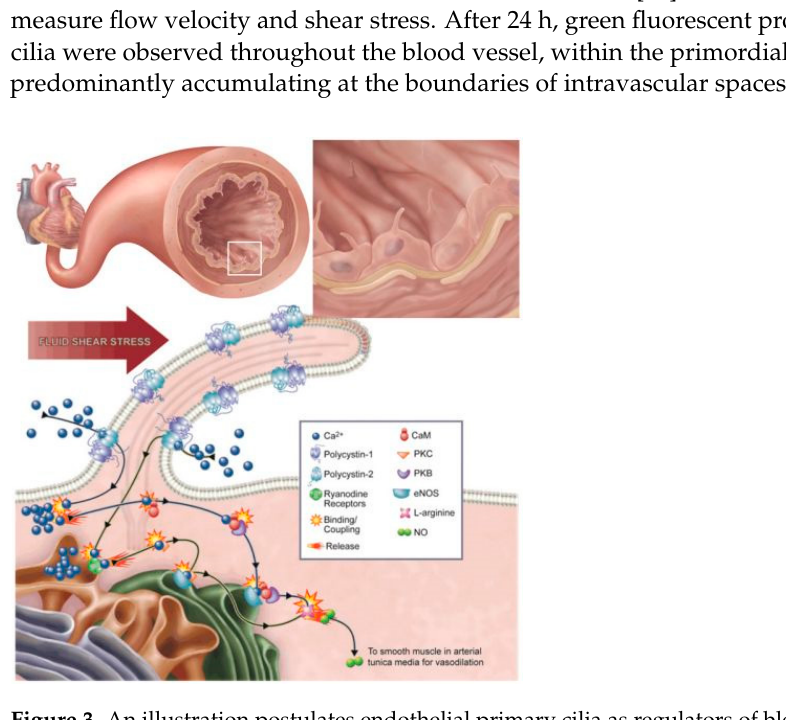
Figure 5. Photomicrograph of primary cilia, denoted by blue arrows. An illustration of GFP-labeled cilial extensions within primordial midbrain channels. Scale bar = 5 µm [22]. GFP refers to the gene that produces green fluorescent protein. The authors suggest that structures labeled with GFP are cilia (Figure 5) [22], which play a functional role in the early stages of cerebral–vascular morphogenesis; however, biologists normally use GFP as a generic protein marker. GFP can attach to and mark proteins with fluorescence, enabling scientists to see the presence of the particular protein in an organic structure. This type of fluorescent marking cannot explicitly identify cilia per se. This is evident as much more than just the “cilia” has been tagged with GFP fluorescence (Figure 5). Control of EC behavior and morphology is critical during vascular formation and remodeling; however, at such a low resolution, it is implausible to clearly identify a distinctive cyto- skeletal profile of cilia. Furthermore, at this resolution, it is also unclear whether one can show the 9 + 2 cytoskeletal structure of the cilium, and supporting evidence from TEM microscopy has never produced proof to suggest the presence of endothelial cilia. What is clear is that GFP fluorescence extends from the soma of the BEC into these projections.